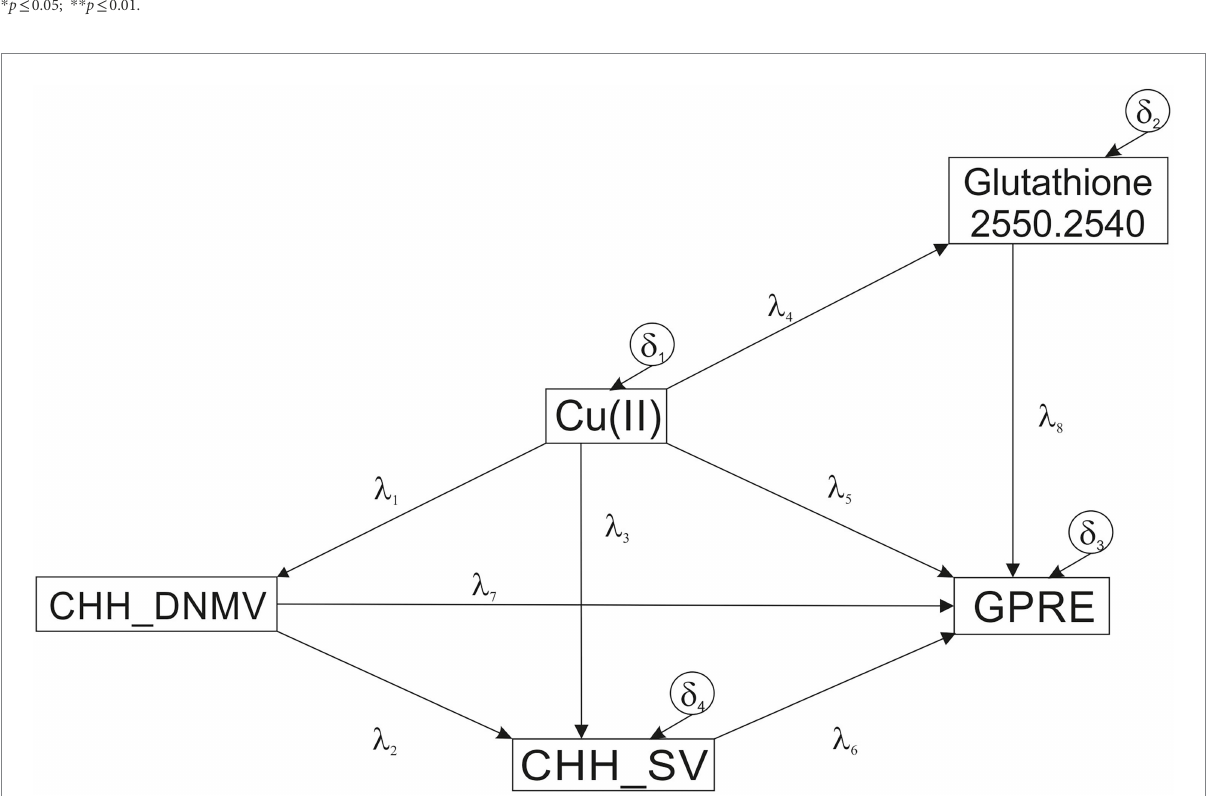
FIGURE 3 The hypothesized SEM model. Cu(II) ions concentration ( μ M); GPRE, green plant regeneration efficiency (number of regenerants per 100 plated anthers); the metAFLP quantitative characteristics concerning sequence variation (CHH_SV) and de novo DNA methylation (CHH_DNMV) between donor plant and its regenerants affecting asymmetric CHH sequence contexts; the 2,550–2,540 cm − 1 is the FTIR spectrum wavenumber range (thiols give the univocal signal) indicating integrated absorbance used in the model; λ 1 – λ 8 path coefficients, δ 1 – δ 4 residuals (experimental errors).